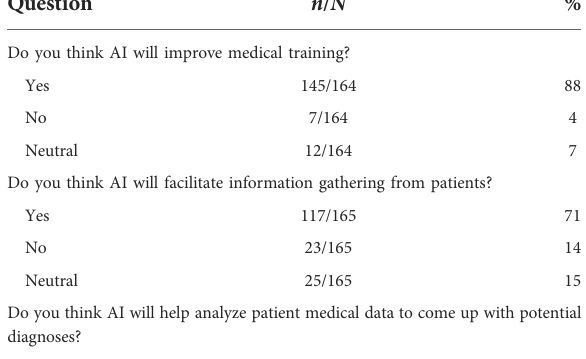
TABLE 1 Survey responses: expected bene fi ts of